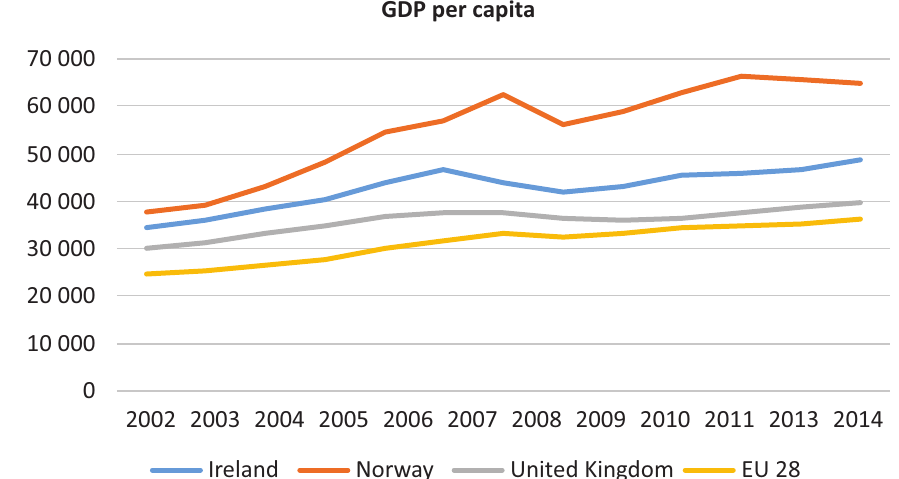
Figure 1. GDP per capita for the three countries and EU average. Source: OECD http://ec.europa.eu/eurostat/web/national- accounts/data/database (Scotland represented by UK figures).